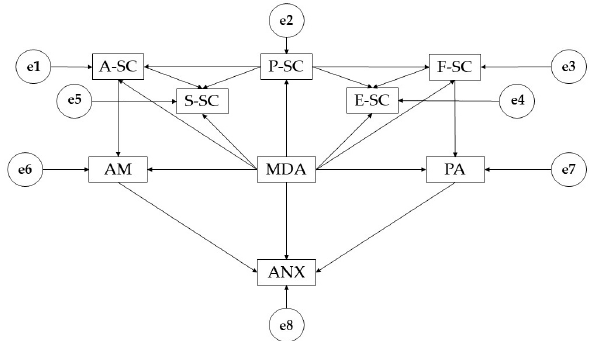
Fig. 1. Theoretical model proposed. A-SC, Academic self-concept; S-SC, Social self-concept; P-SC, Physical self- concept; E-SC, Emotional self-concept; F-SC, Familiar self- concept; MDA, Mediterranean Diet Adherence; AM, Average Mark; PA, Physical Activity; ANX,